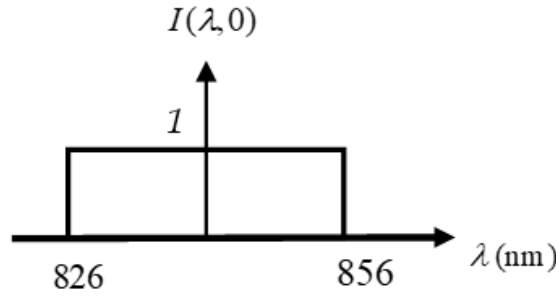
Figure 4. The spectral distribution of a unit uniform spectrum.